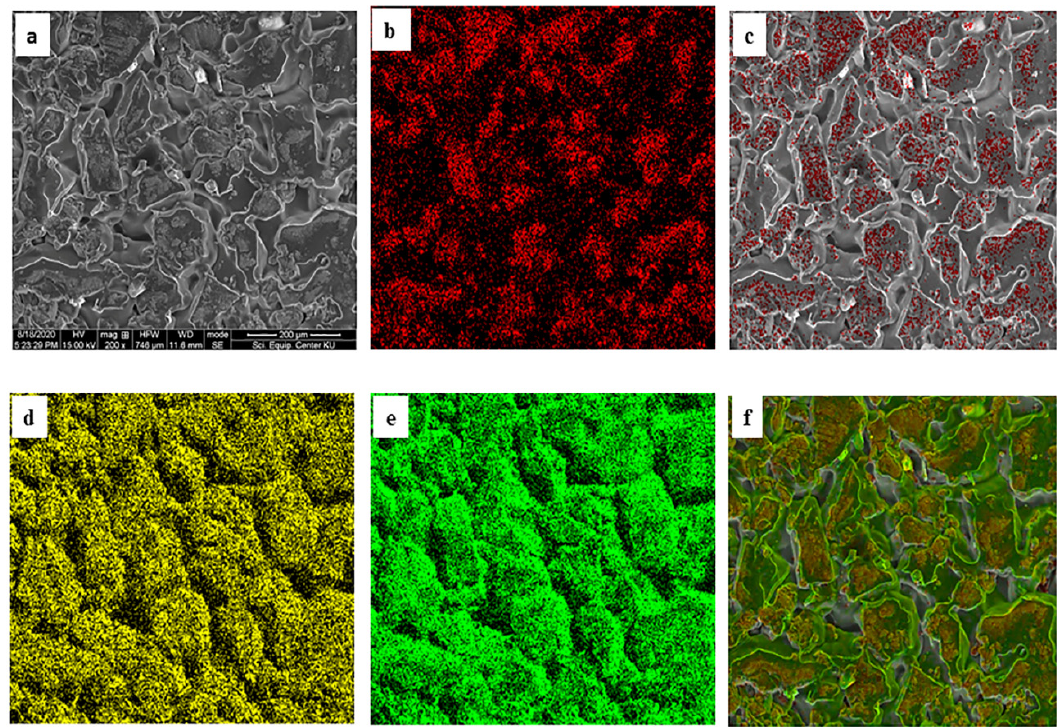
Figure 3. SEM micrograph ( a ) PVA/BM60 (200 × ), EDS elemental mapping of ( b ) Fe (red), ( c ) PVA/BM60_Fe mix, ( d ) O (yellow), ( e ) C (green) and ( f ) PVA/BM60_Fe_O_C mix composite film.